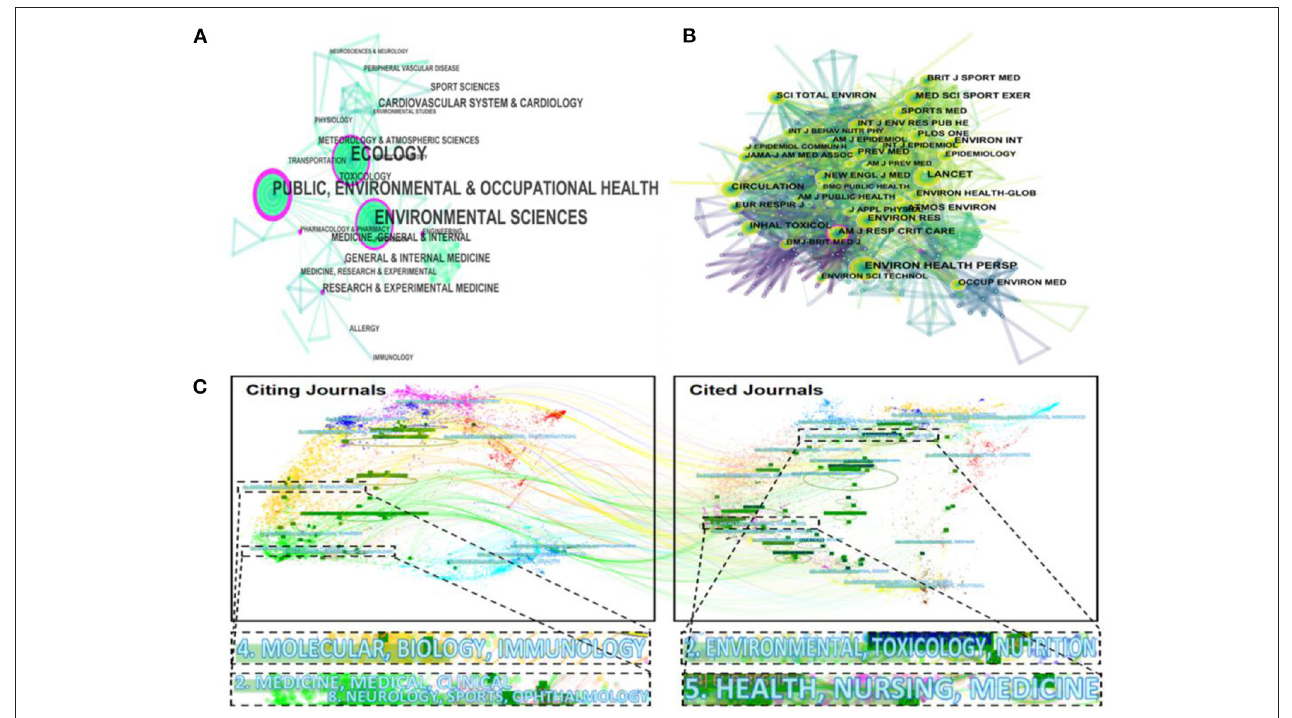
FIGURE 4 | The map of disciplines (A) , cited-journals (B) , and a dual-map overlay (C) of publications in the AP-PE